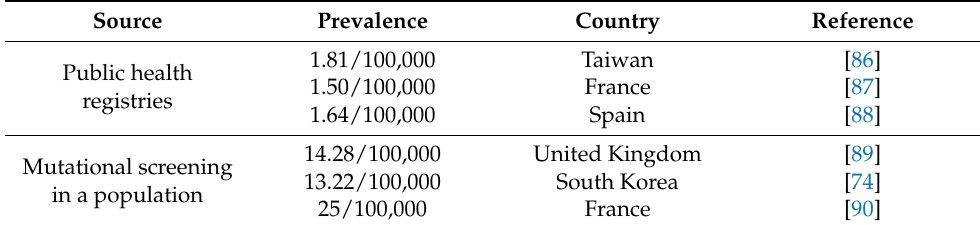
Table 3. Prevalence of Wilson’s disease in several